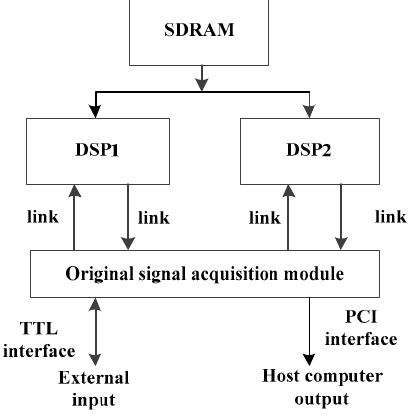
Figure 9. Frame diagram of hardware implementation.